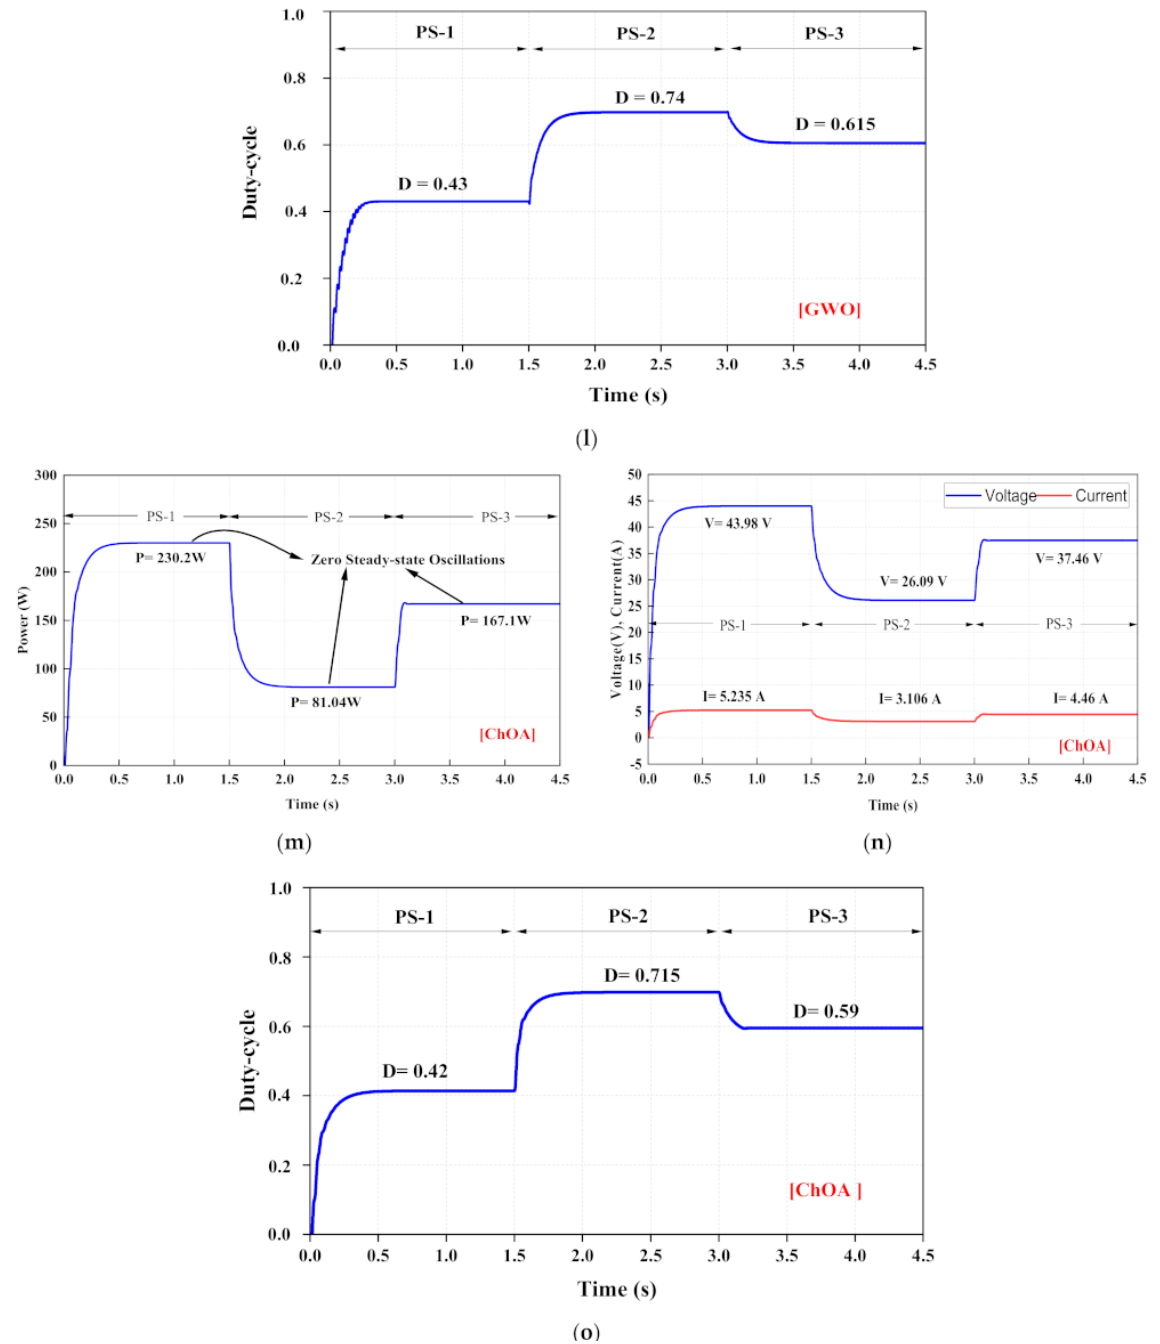
Figure 15. GMPP tracking profile of modified P&O, PSO, FPA, GWO, and proposed ChOA under non-uniform irradiance variations: ( a , d , g , j , m ) power characteristics, ( b , e , h , k , n ) voltage and current characteristics, ( c , f , i , l , o ) duty-cycle